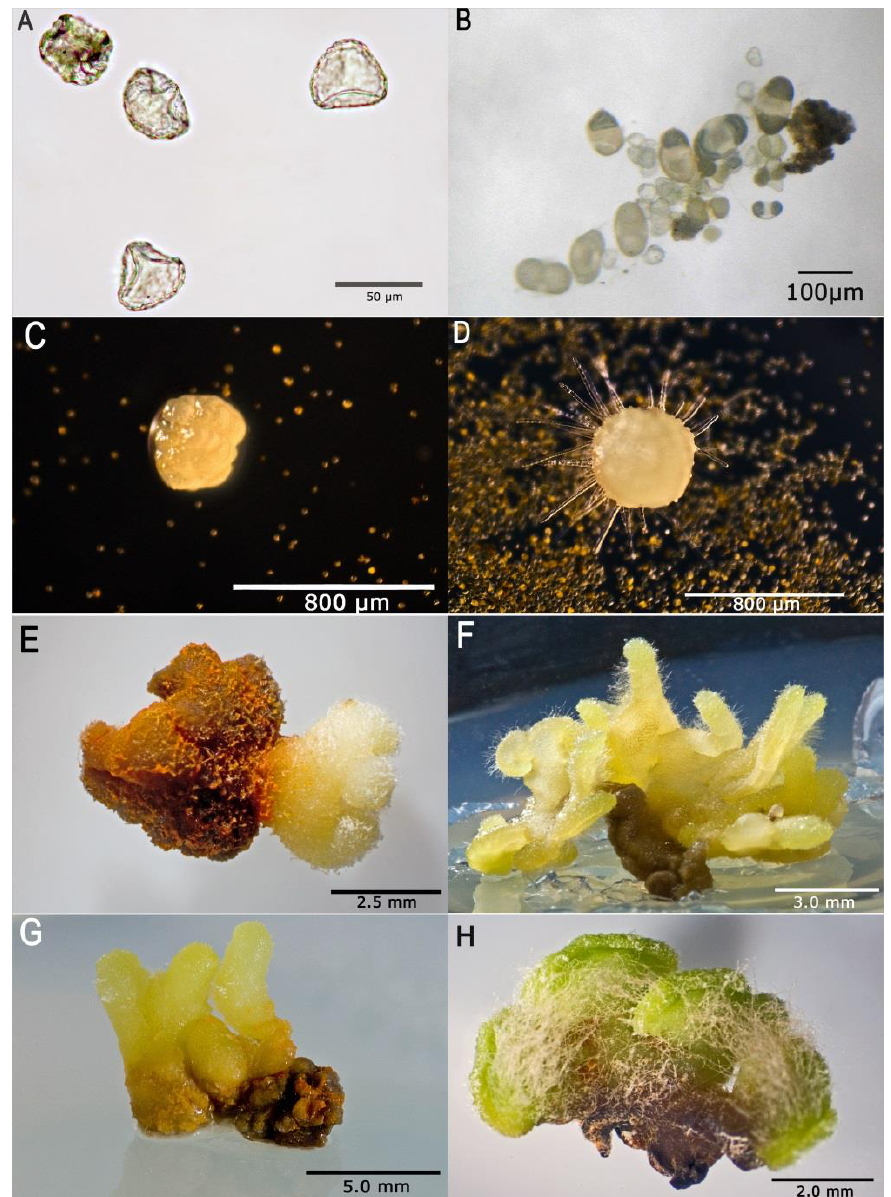
Figure 2. In vitro culture of spores and gametophytes of Huperzia selago for multiplication and an alkaloid production. ( A ) Spores on growth media for germination. ( B ) Germinating spores after 7 months of culture. ( C ) Young prothallus consisting of a few cells after 2–4 weeks. ( D ) Small spherical gametophytes after 3 months of culture. ( E – H ) Lateral view of different morphological types of the mature gametophyte and its late developmental stages.